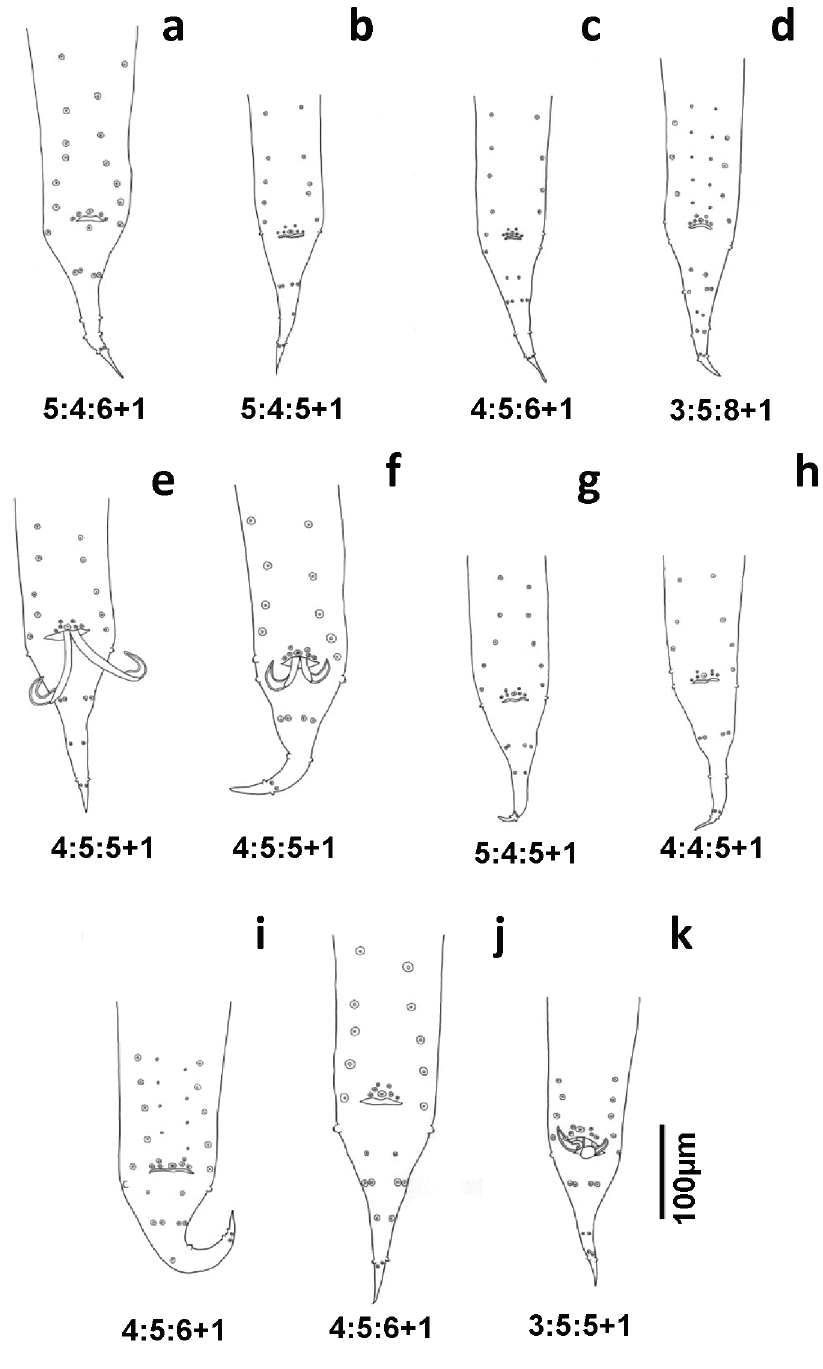
Figure 2 - Number and arrangement of caudal papillae of A. hylambatis from different amphibian hosts and localities in Argentina. (a) L. bufonius from Corrientes. (b) L. bufonius from las lomitas. (c) L. bufonius from Taco Pozo . (d) D. muelleri from las lomitas. (e) R. major from Concepción del Bermejo. (f) R. major from Ingeniero Juárez. (g) R. major from las lomitas. (h) R. major from Taco Pozo. (i) R. arenarum from la Plata. (j) R. arenarum from San Juan. (k) P. santafecinus from